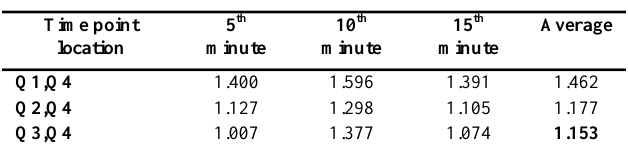
Table 2. Average value of ( ) for different locations of extra point in